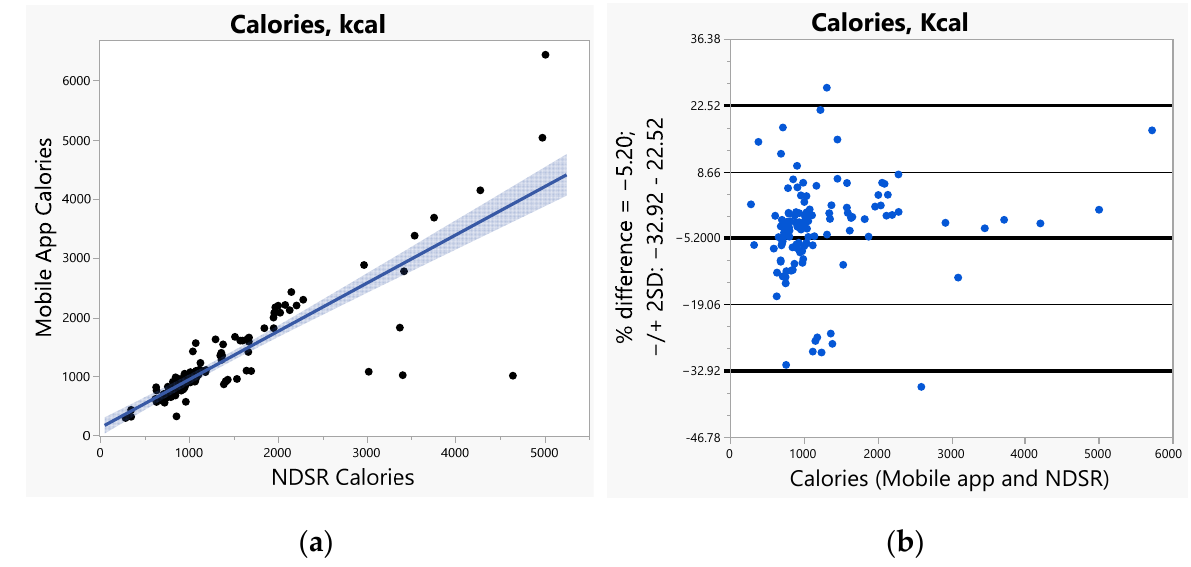
Figure 1. ( a ) Correlation, ( b ) Bland-Altman plots between the internet-based application and Nutri- tion Data System for Research (NDSR) on total calories.